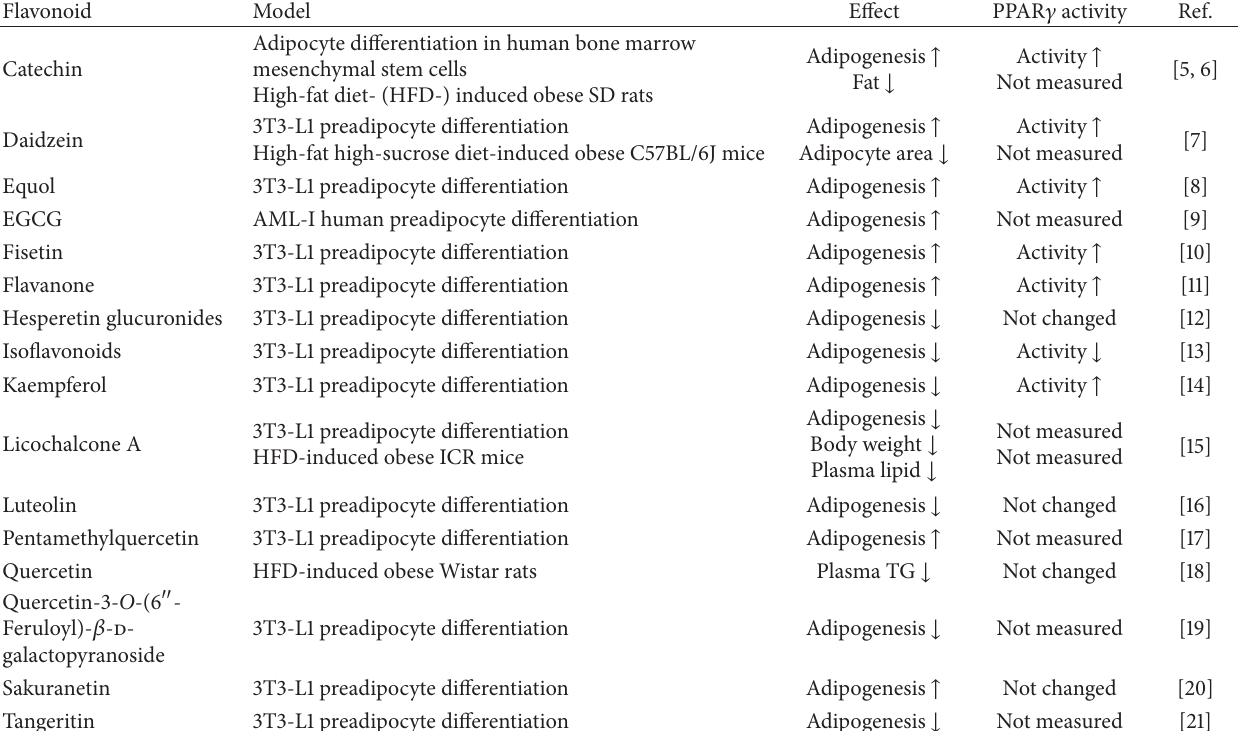
Table 3: Summary of recent publications on the effects of flavonoids: adipogenesis and PPAR 𝛾 activity.